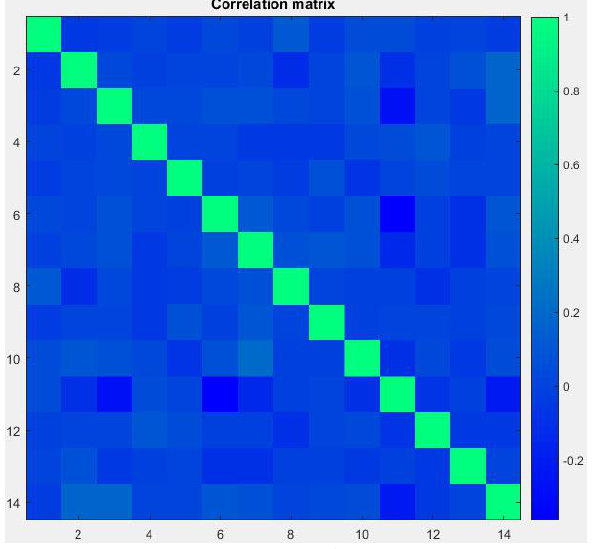
Figure 3. Correlation matrix of explanatory variables